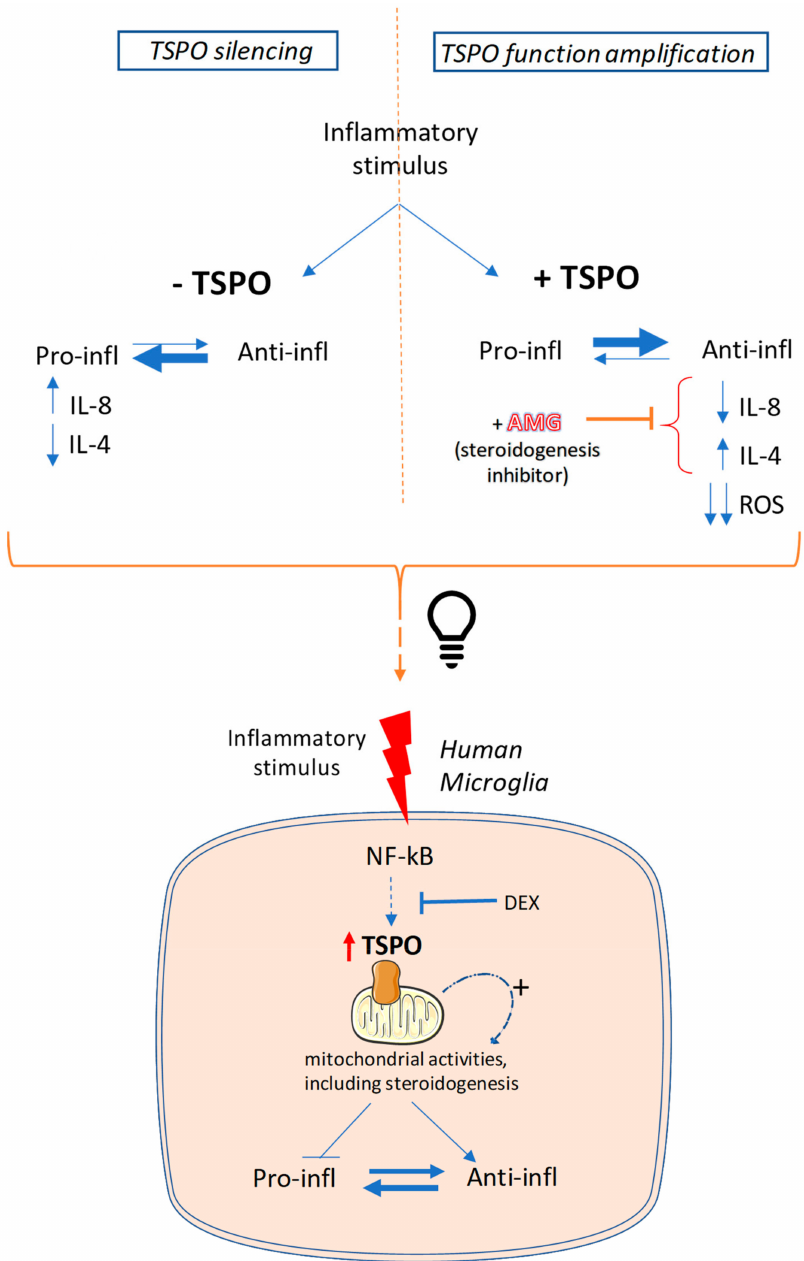
Figure 8. The suggested role of TSPO in orchestrating di ff erent cellular activities during inflammation of human microglia. In the above panel, the two experimental approaches are reported: (i) TSPO silencing ( − TSPO) and (ii) TSPO function amplification by using TSPO ligands ( + TSPO). In the -TSPO approach, the balance is shifted toward the pro-inflammatory phenotype (as indicated by the thicker arrow directed to the left). In the + TSPO approach, the balance is shifted toward the anti-inflammatory phenotype (as indicated by the thicker arrow directed to the right). This latter phenomenon is abolished when the steroidogenesis inhibitor aminoglutethimide ( + AMG) is used. These observations indicate that the expression / activation of TSPO is related to the switch of microglial phenotype. The suggested hypothesis is outlined in the lower panel. The inflammatory stimulus activates the NF- κ B pathway, which in turn could stimulate the TSPO overexpression, as a result of the binding of this transcription factor to the TSPO promoter. Our data suggest that TSPO is able to activate ( + ) specific mitochondrial activities, such as ROS production and neurosteroidogenesis, in order to counteract the pro-inflammatory